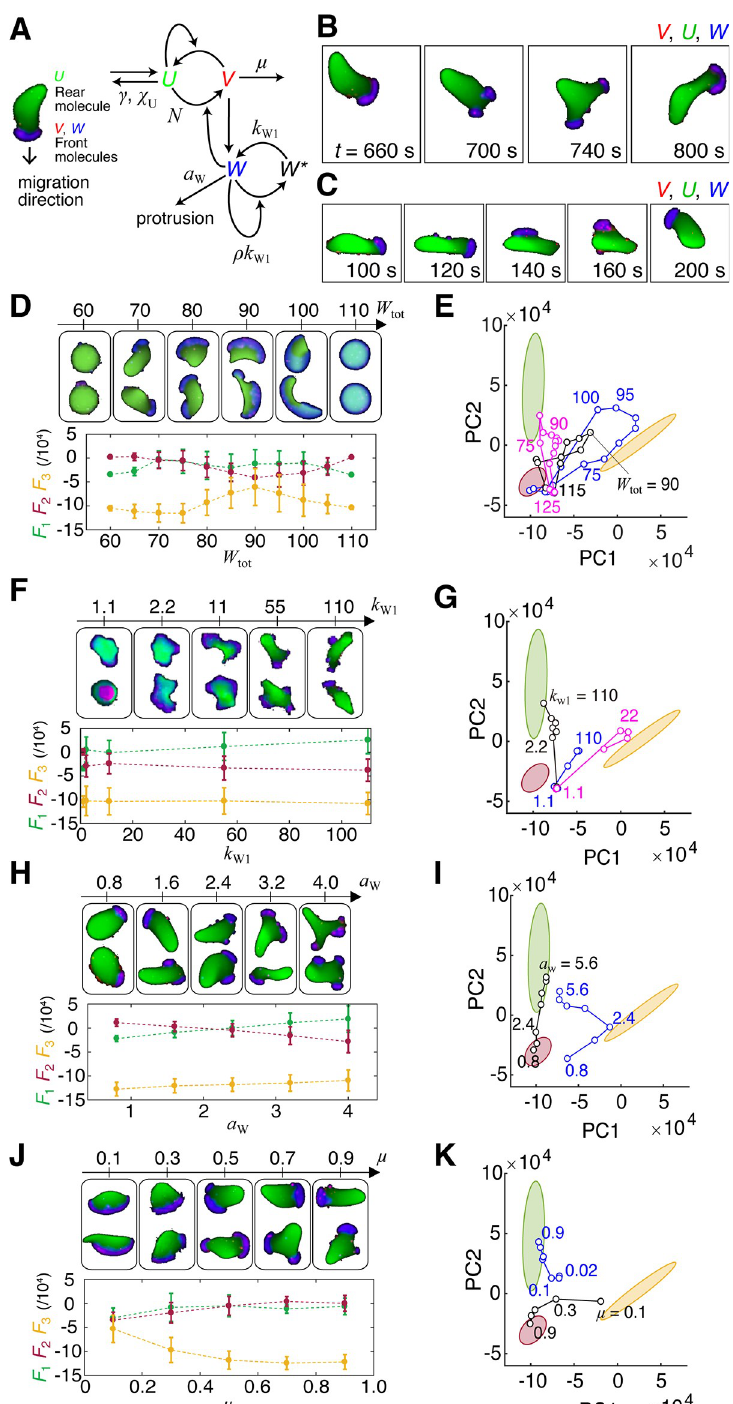
Fig 2. Degree of leading edge expansion and the balance between pseudopod formation and polarity persistence can account for the main morphology feature. (A) Schematics of the dynamical model. Self-amplifying and excitatory synthesis from U to V [70] induces protrusion factor W which can be prolonged by the bistable dynamics (Eq 2). The reaction takes place in a region ϕ = 1 governed by interface physics according to the phase-field equation (Eq 1). The membrane expands outward into an unoccupied region ϕ = 0 in the direction perpendicular to the border at a rate proportional to local W . Main parameters ( χ U , γ , μ , k W1 , ρ , a W ) are denoted along the associated reaction steps. (B, C) Representative model behavior (overlay plots for U , V , W ); front splitting (B) and pseudopod formation